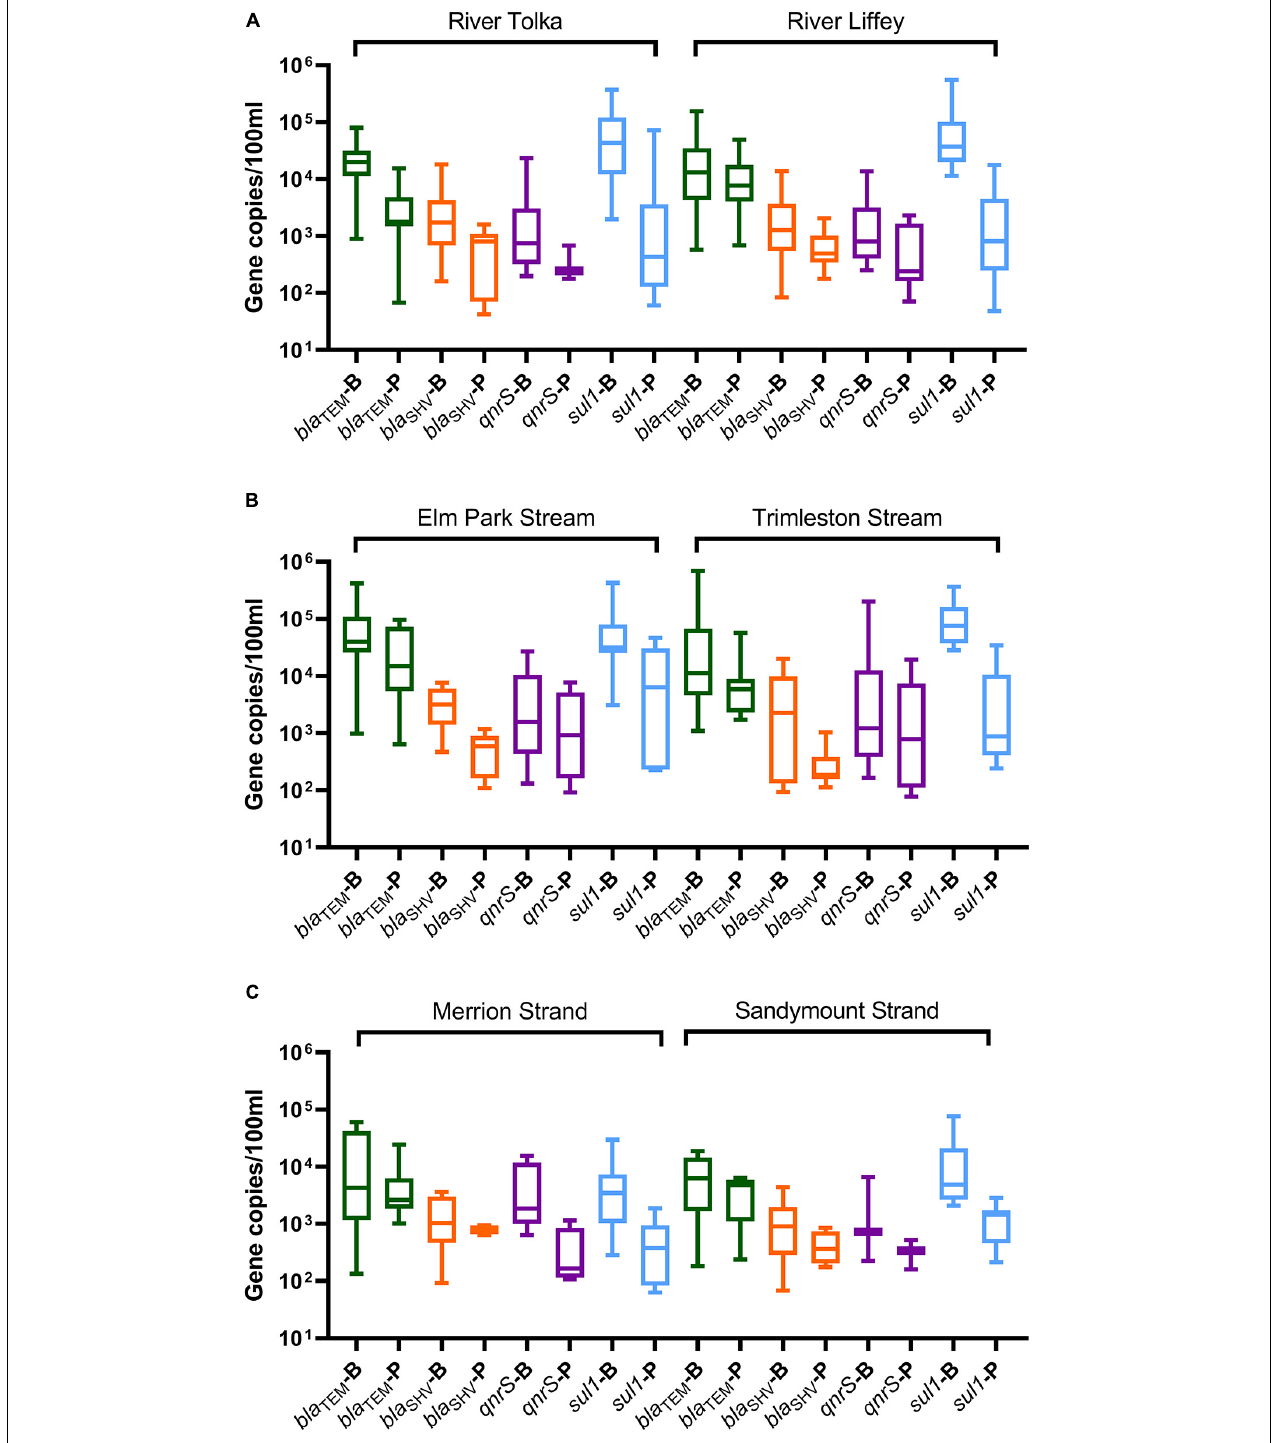
FIGURE 6 | Boxplot representation of the ARGs concentrations in the bacterial (B) and bacteriophage (P) fractions in water samples from (A) rivers (Tolka and Liffey), (B) streams (Elm Park and Trimleston), and (C) bathing waters (Merrion and Sandymount Strands). In the boxplots the lower hinge represents 25% quantile, upper hinge 75% quantile, and center line the median. The whiskers show the maximum and the lowest value. Only values above the quantification limit are plotted.